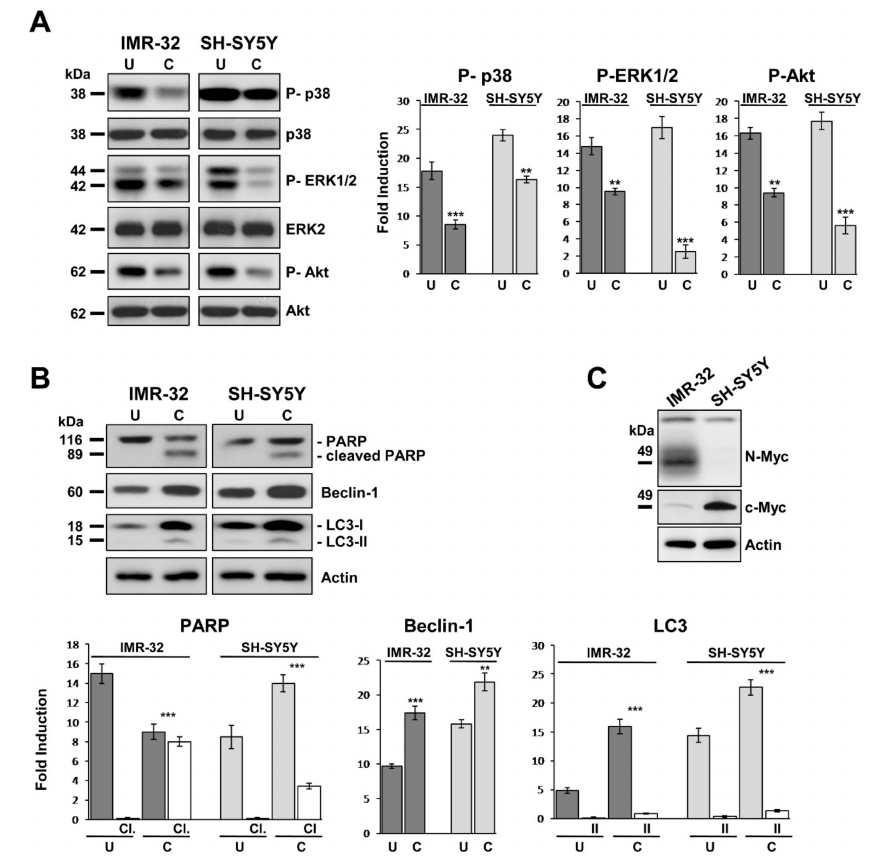
Figure 2. Curcumin reduces activation of MAP-kinases and induces apoptosis and autophagy in neuroblastoma cells. ( A ) Protein lysates from IMR-32 and SH-SY5Y cells cultured in 10 or 20 µ M curcumin respectively for 48 h (C = curcumin) were collected and subjected to Western blot analysis with anti-phospho-p38, anti-phospho-ERK 1 / 2, and anti-phospho-Akt antibodies. ( B ) The same protein lysates were blotted again and probed with anti-PARP for apoptosis (cl = cleaved PARP), and anti-Beclin-1 or anti-LC3 antibodies for autophagy (II = LC3-II). Untreated cells (U) were cultured with 0.1% DMSO. Protein levels were quantified by densitometry, normalized to the content of the loading control protein (each total protein or actin) and visualized by histograms. Data are representative of three independent experiments ± SD. ( C ) MYCN and c-MYC expression in IMR-32 and SH-SY5Y cell lines displayed by Western blot (** p < 0.01; *** p <